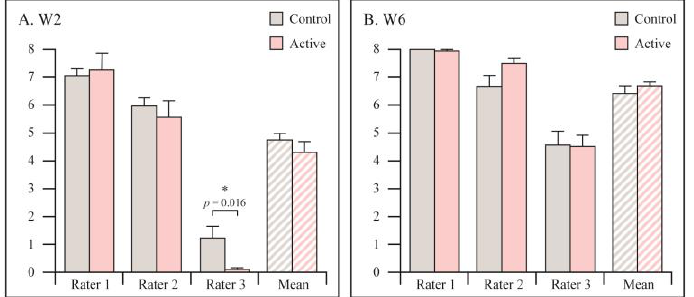
Figure 4. Radiological assessment of fracture healing at 2 and 6 weeks by X-rays, using RUSS. Graphs are reported as mean ± SE. Student’s t -test. ( A ) At 2 weeks follow-up. ( B ) At 6 weeks follow-up.* Statistically significant.